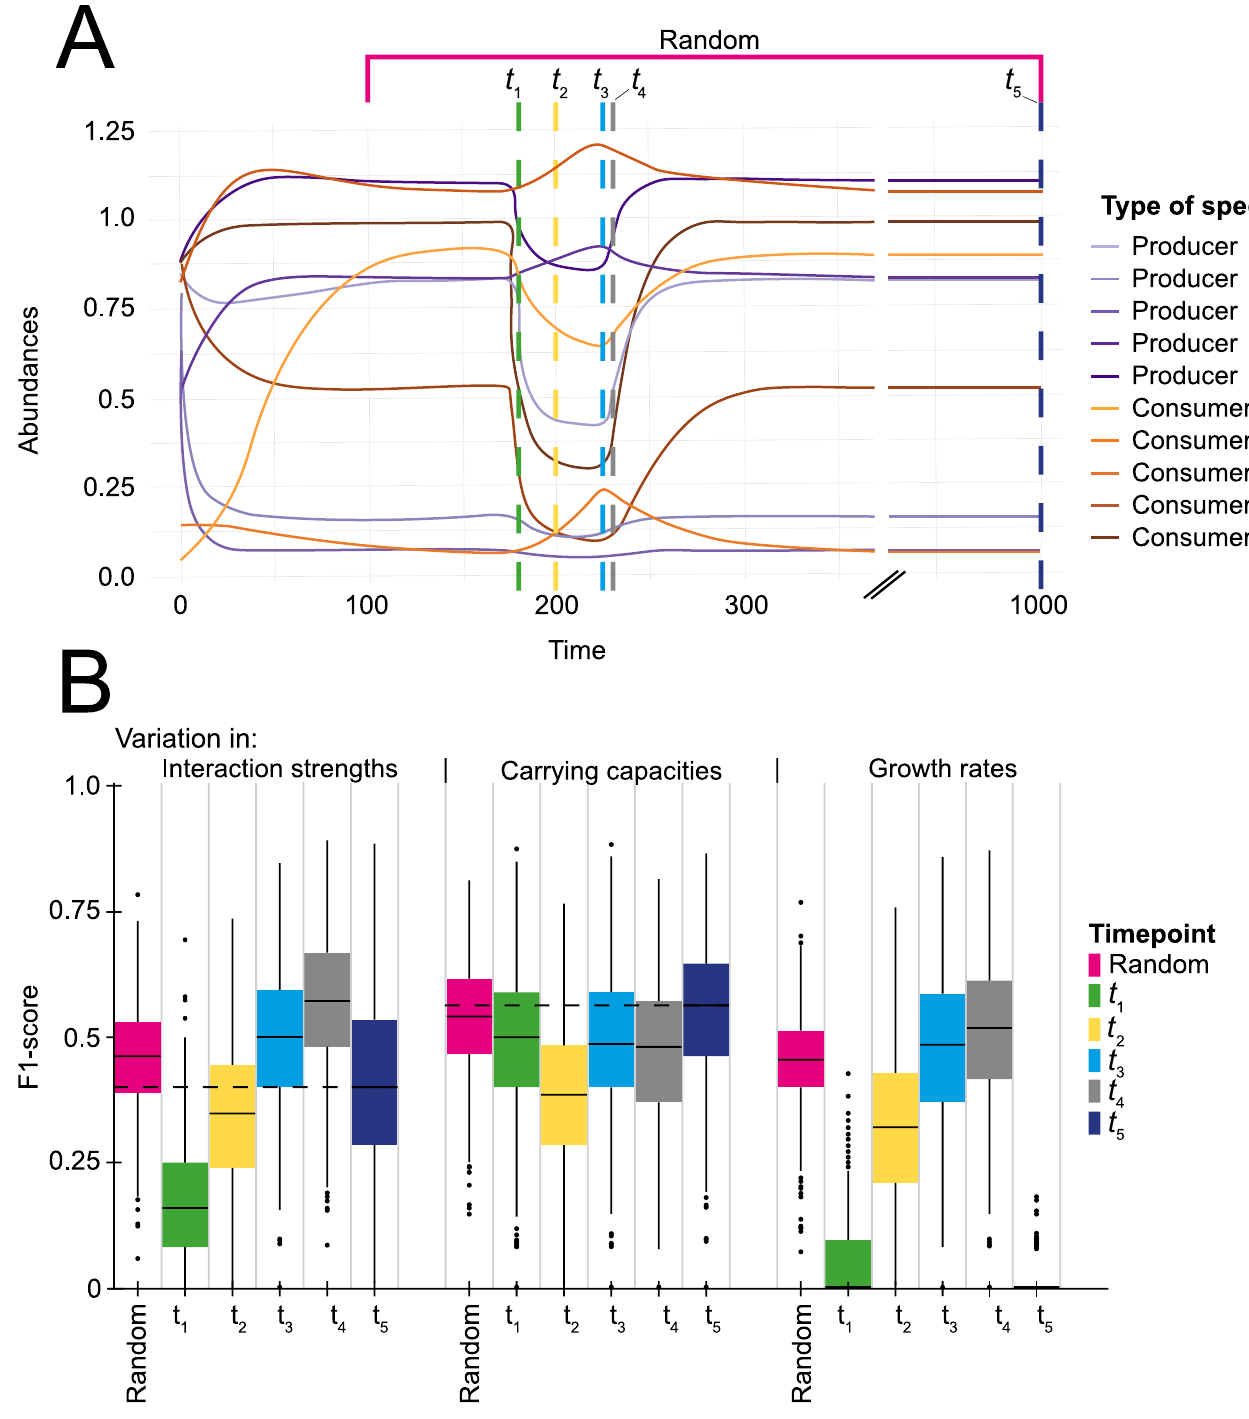
Fig 5. The effect of a perturbation on correlation-based network inference. (A) Example of a timeseries. Dashed lines represent sampling timepoints. Sampling was performed during the perturbation ( t = green, t = yellow, t = blue and t = grey) and at equilibrium ( t = dark blue). Alternatively, sampling was performed 1 2 3 4 5 randomly between t = 100 and t = 1000 (random = pink). (B) Results (F1-scores) of network inference for sampling at various timepoints. After a perturbation all species grow back to their original equilibrium. The bars of the boxplots indicate the variability outside the middle 50% (i.e., the lower 25% of scores and the upper 25% of scores). Dashed lines represent median results of sampling during